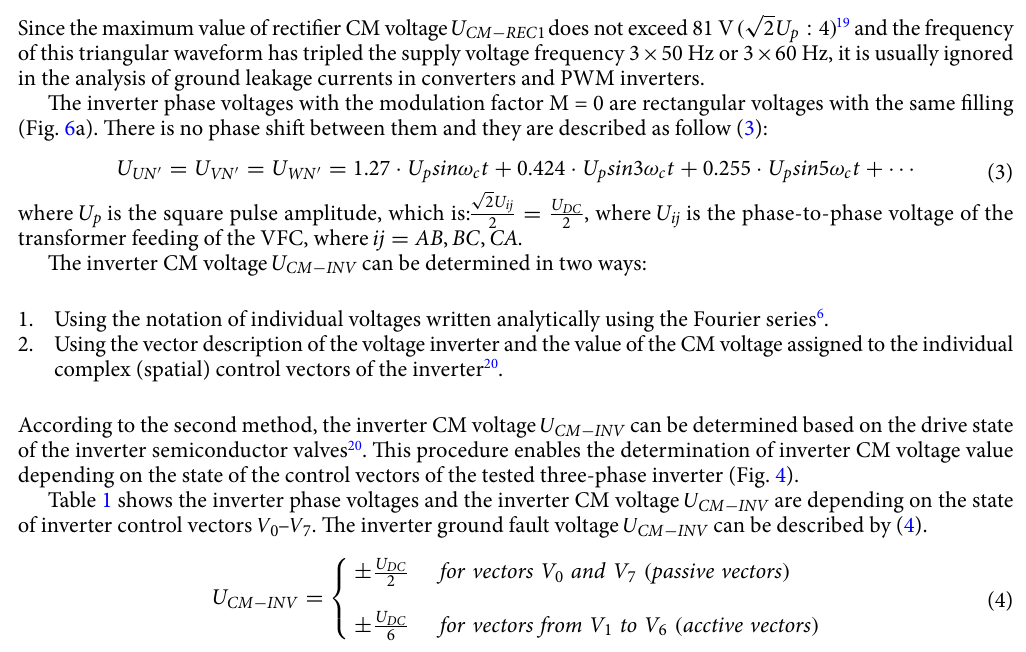
Figure 6. Waveforms of CM voltage and CM ground current with 1 k (cid:31) resistance for modulation factor: ( a ) M 0 , ( b ) M 0.85 = =